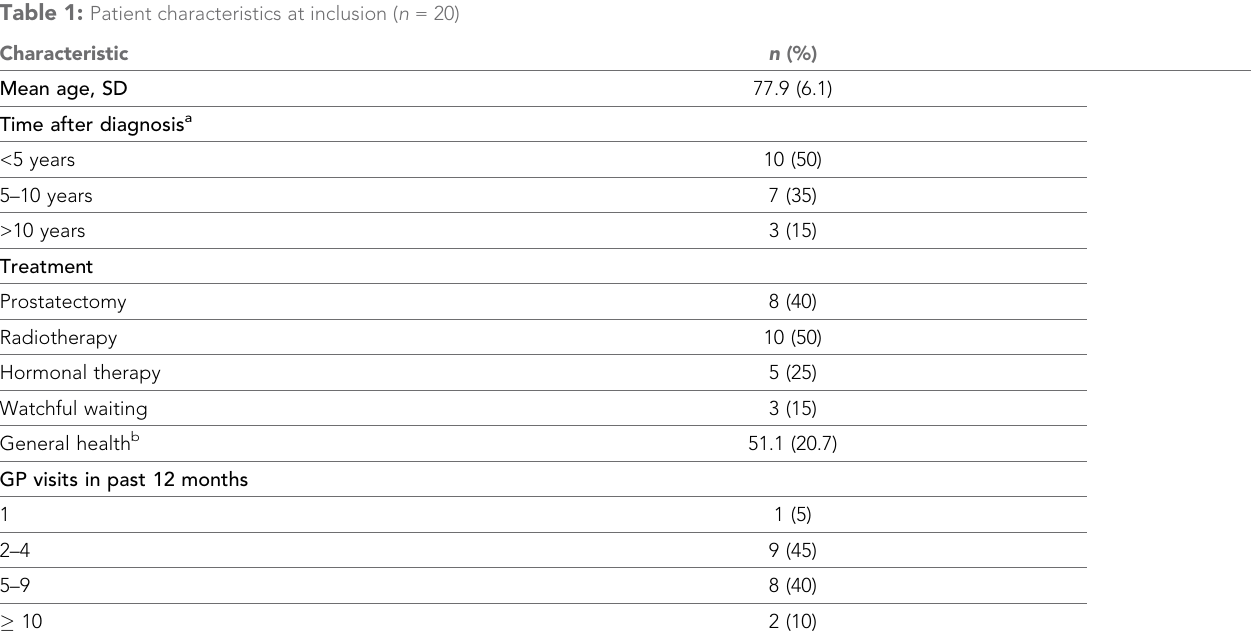
Table 1: Patient characteristics at inclusion ( n = 20)